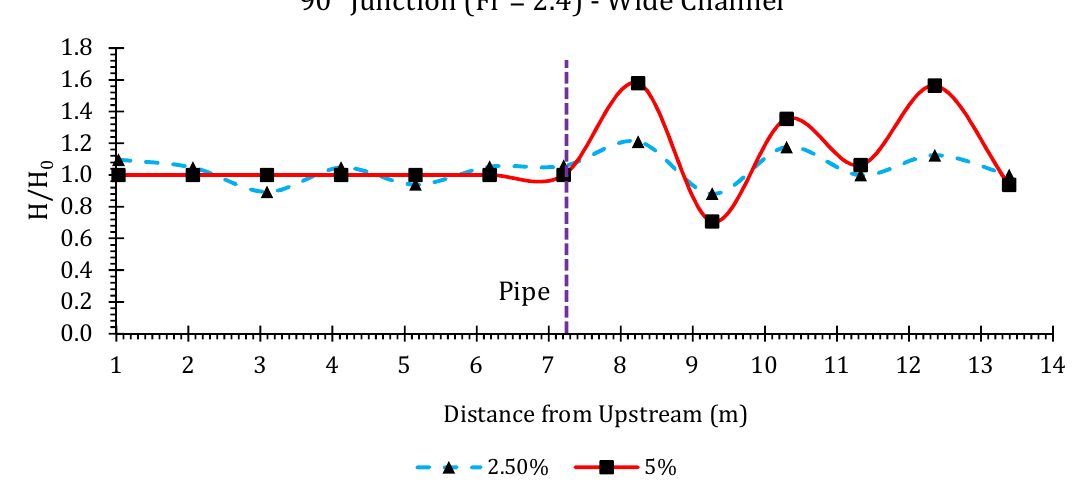
Figure A18. Water height ratios in a 90° junction for Fr = 2.4 in the wide channel.